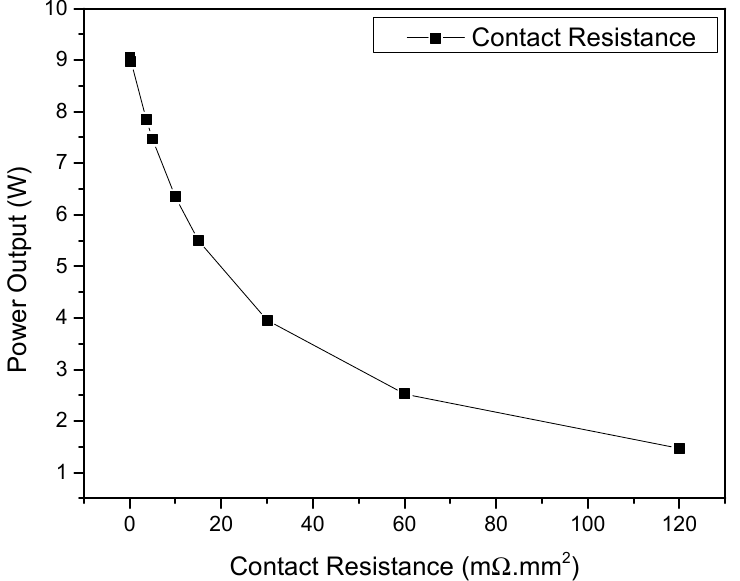
Figure 11. Contact resistance influence on the power produced by a silicide-tetrahedrite TEG (opti- mized geometry) for fixed hot- and cold-side temperatures of 568 and 321 K, respectively.